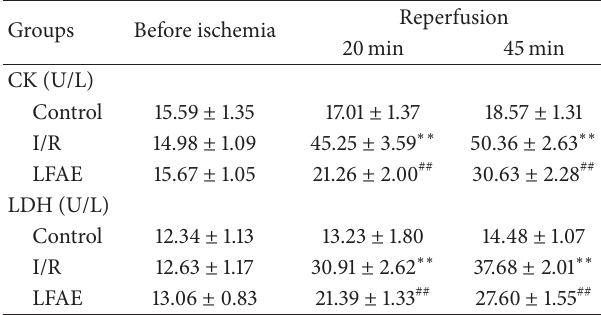
Table 1: Effect of the aqueous extract of lavender flower (LFAE) on levels of CK and LDH in coronary flow of ischemia/reperfusion injury ( 𝑥 ± 𝑠 , 𝑛 = 8 ).